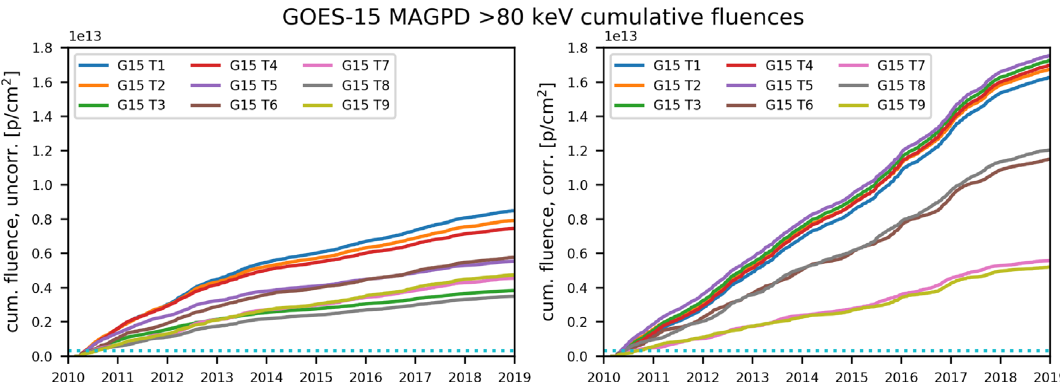
Fig. 11. Cumulative daily >80 keV proton fl uences for each GOES-15 MAGPD telescope, March 2010 to December 2018, (left) uncorrected and (right) corrected. The dotted line indicates the approximate >60 keV proton fl uence accumulated by a MEPED proton telescope in low- earth orbit over 9 years, estimated from Figure 9 of Sandanger et